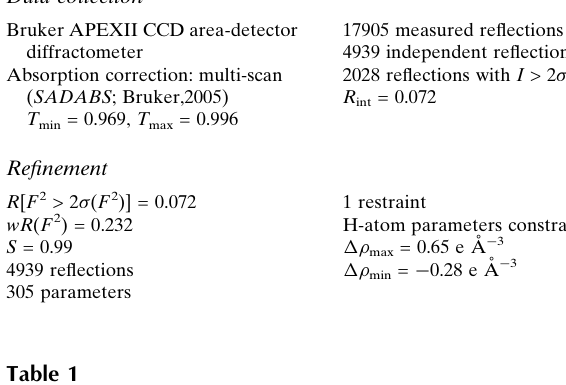
Hydrogen-bond geometry (A˚ , (cid:1)